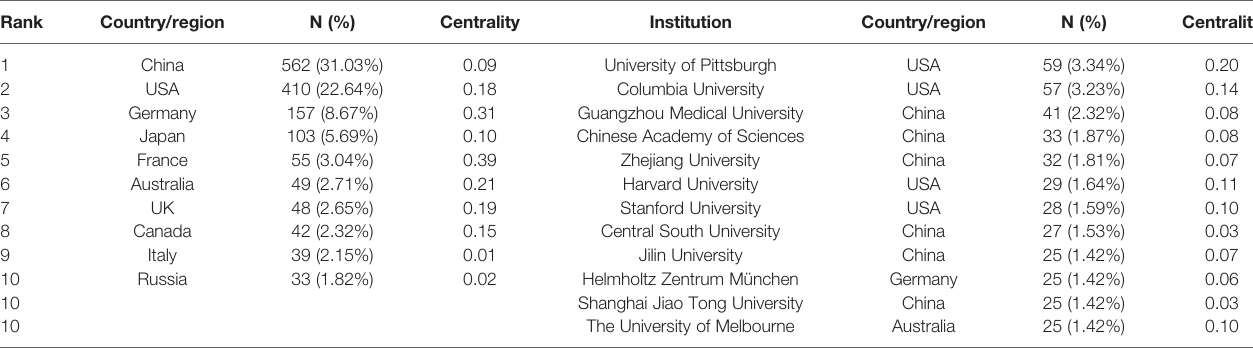
TABLE 3 | The top 10 countries/regions and institutions involved in ferroptosis research.